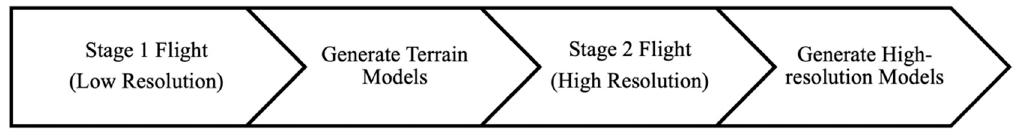
Figure 2. Workflow of the proposed approach in this research.